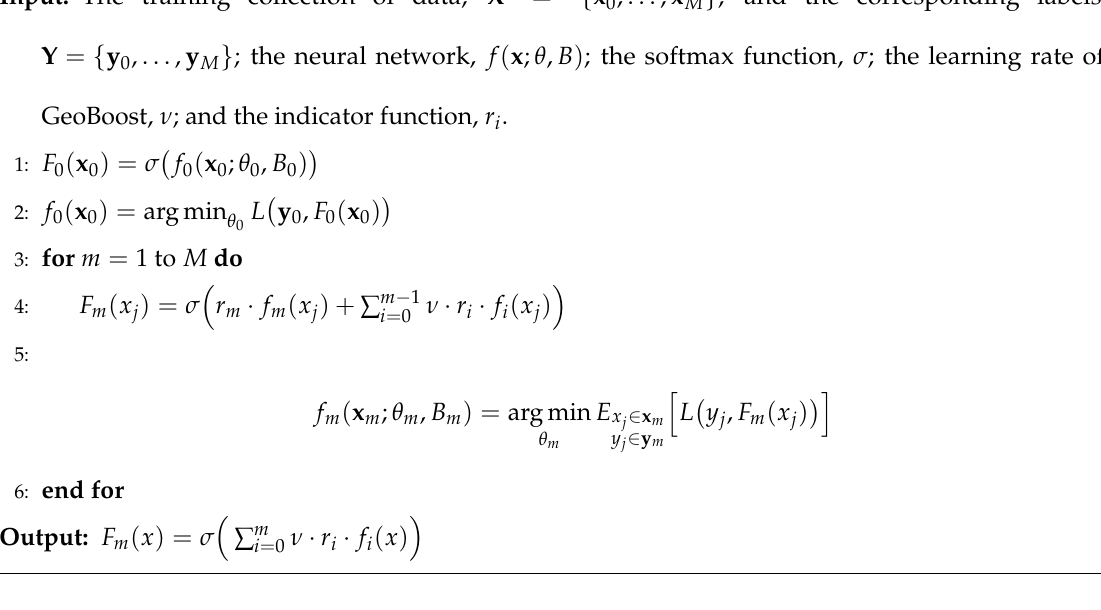
Algorithm 4 The algorithm of GeoBoost with learning